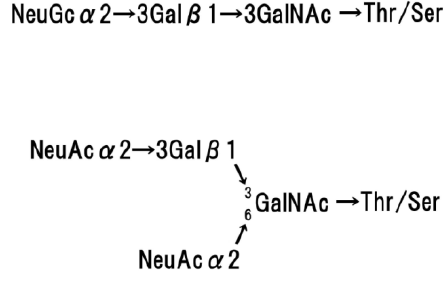
Figure 5. Basic structure of O-linked oligosaccharides of glycophorin A.